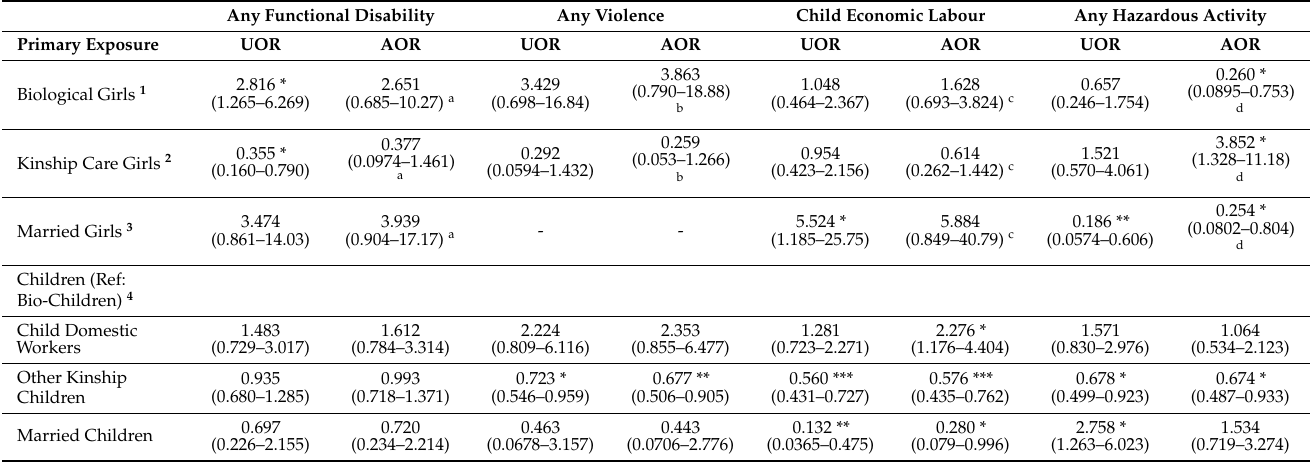
Table 10. Child categories associated with disability, violence, Child Labour (economic activities) and hazardous work ( N =